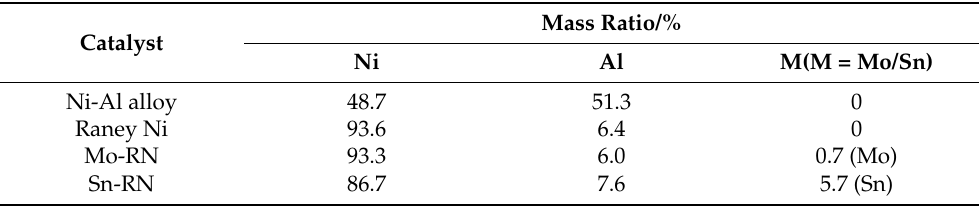
Table 1. Composition of precursor alloy and modified Raney Ni